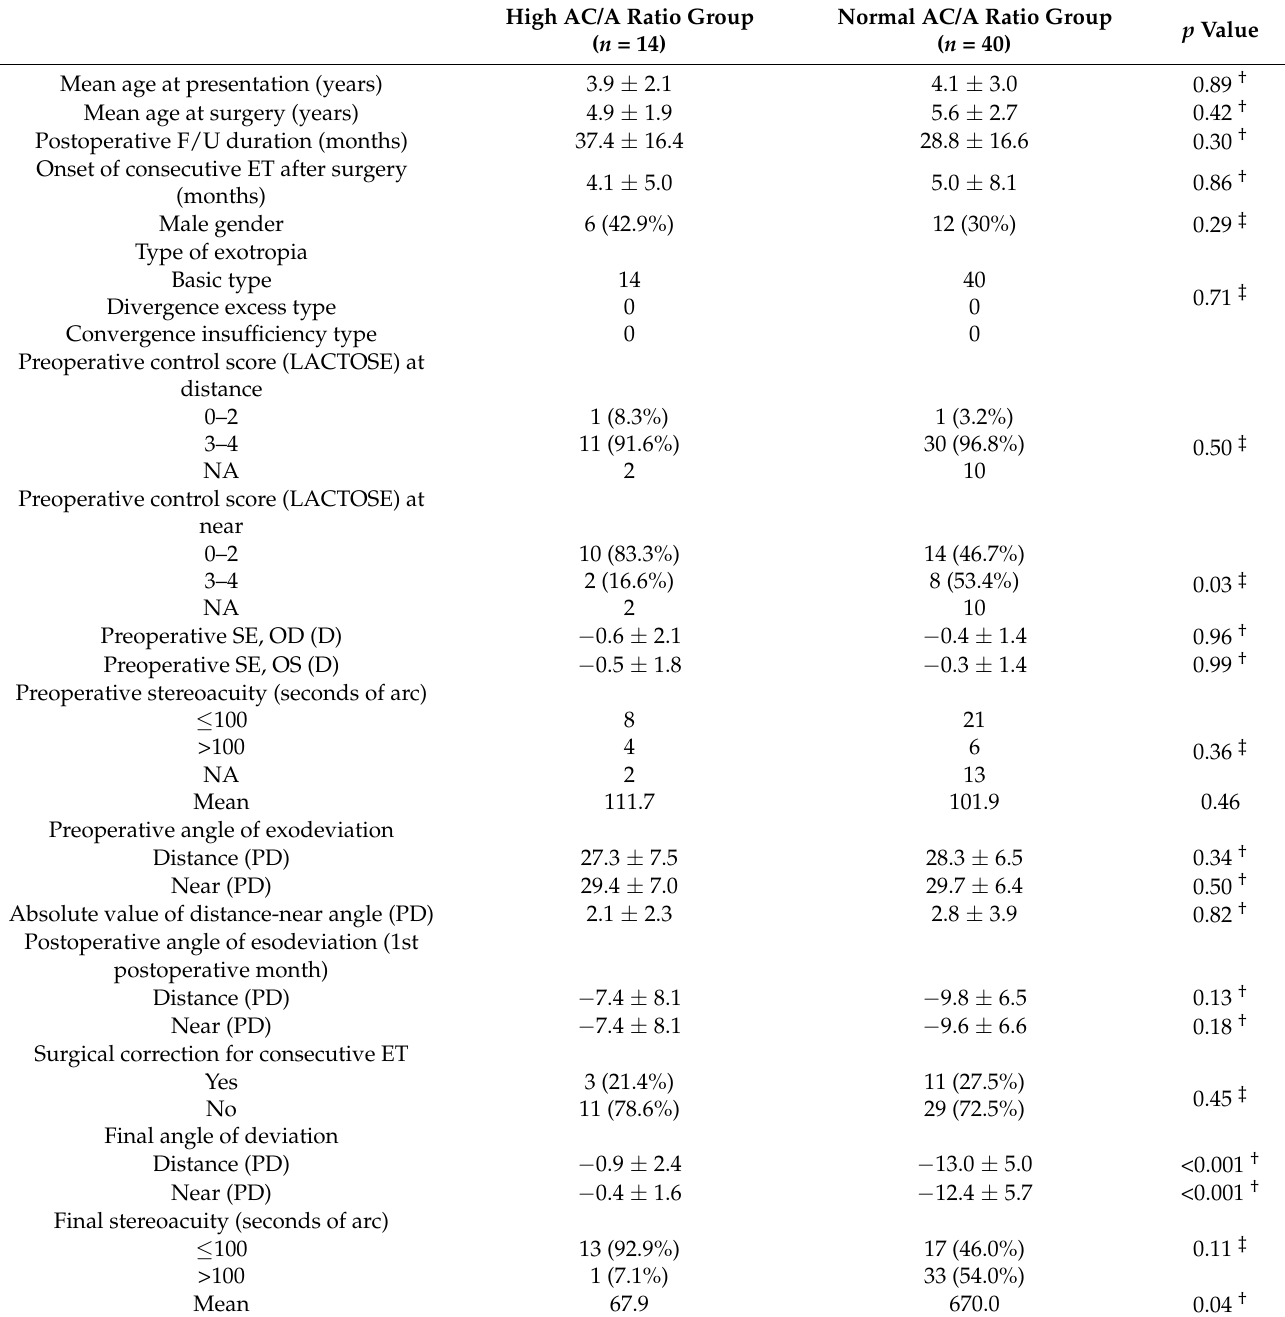
Table 1. Comparison of the pre- and postoperative characteristics between high AC/A and normal AC/A consecutive ET